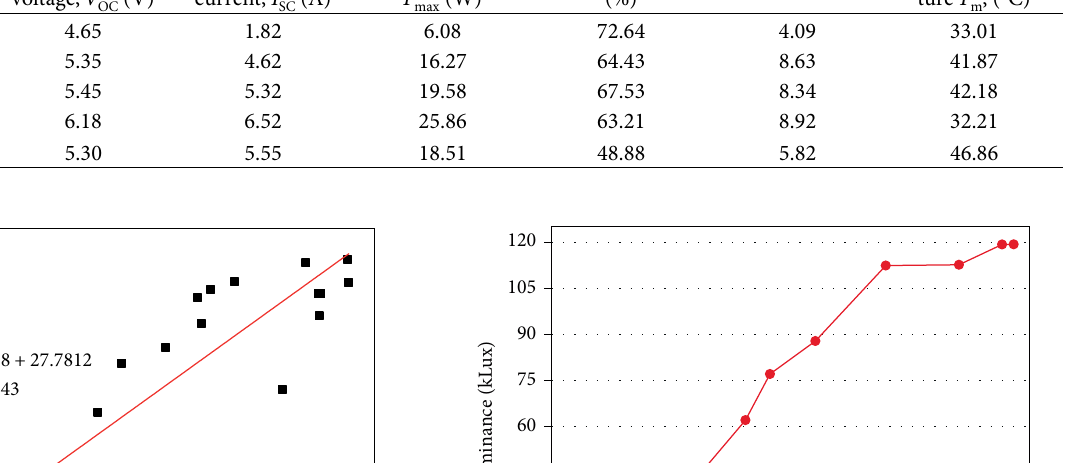
Table 3: Results of electrical measurements investigating the effects of irradiance and temperature. Irradiance, 𝐺